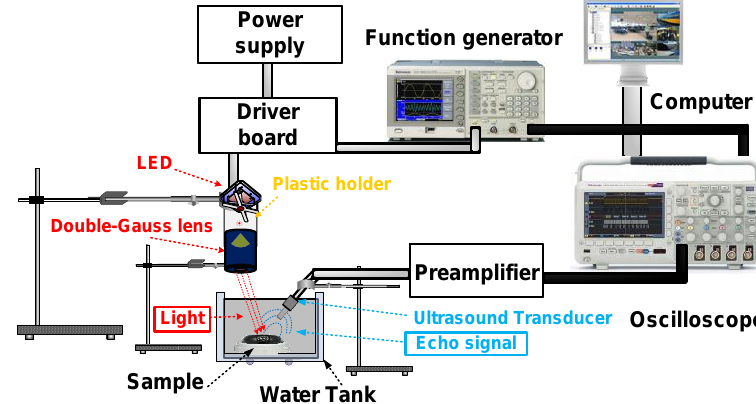
Figure 10. Experimental optoacoustic system with designed double-Gauss lens. The sample was placed in a tank filled with de-ionized water and water temperature remained constant throughout the experiments.